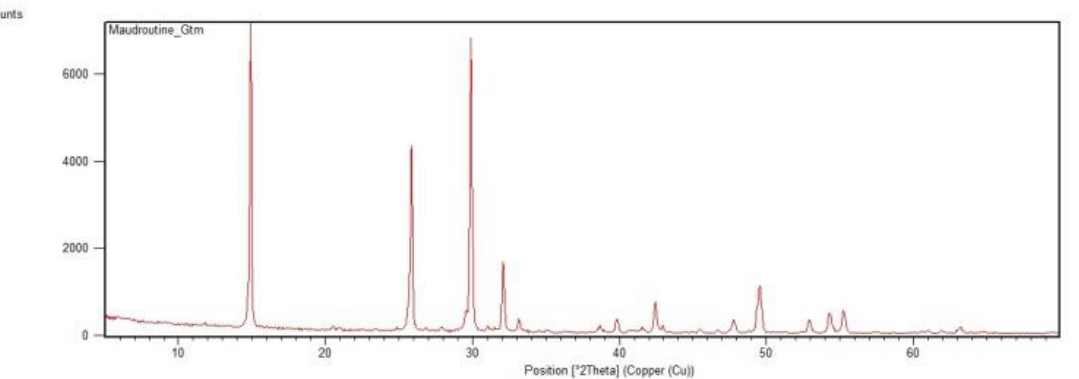
Figure 1. Rietveld refinement of X-ray diffraction of gypsum binder.